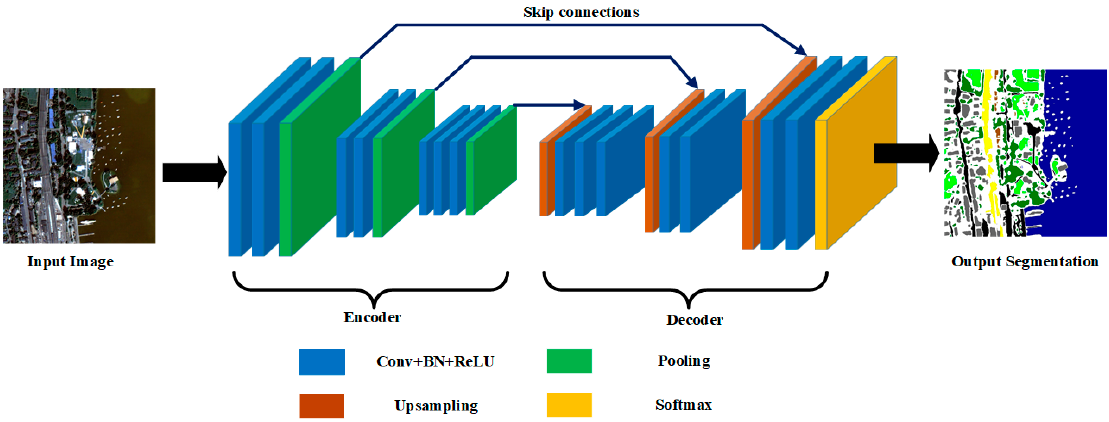
Figure 1. An illustration of encoder-decoder-based FCN architecture for semantic segmentation .